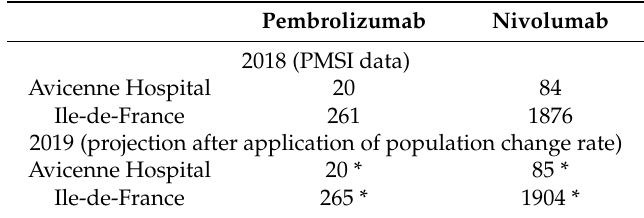
Table 2. Calculation of the population of patients treated with ICI in Avicenne Hospital and Ile-de-France for lung cancer (PMSI data).